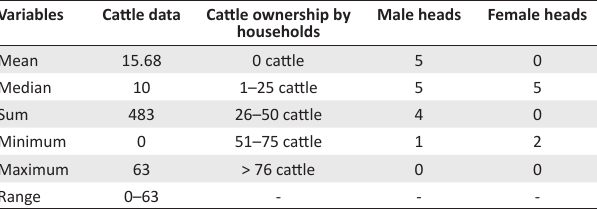
TABLE 4: Cattle ownership in 2012 at Ncunjane ( n =